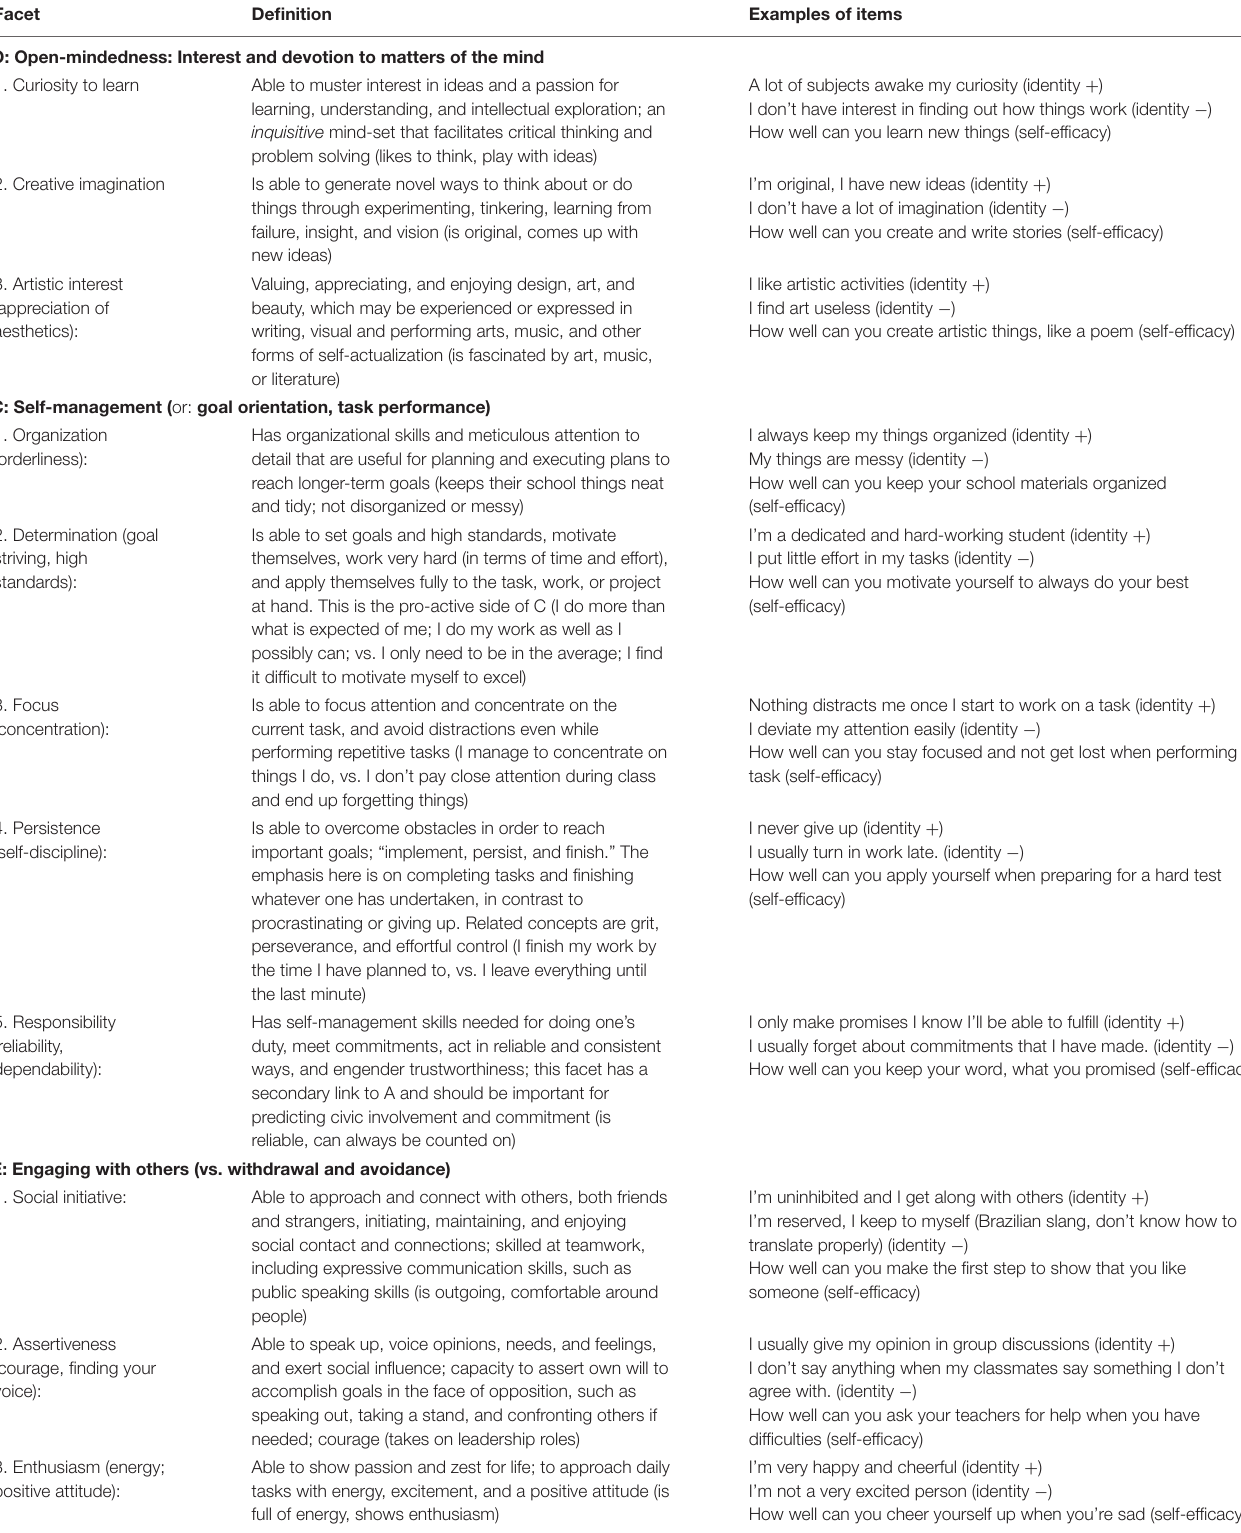
TABLE 2 | Proposed socio-emotional skills domains, facets, and item examples for Senna-2. Facet Definition Examples of